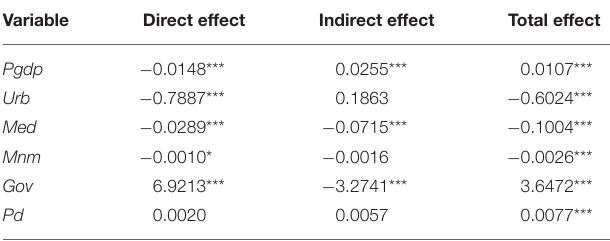
TABLE 9 | Effect decomposition results of